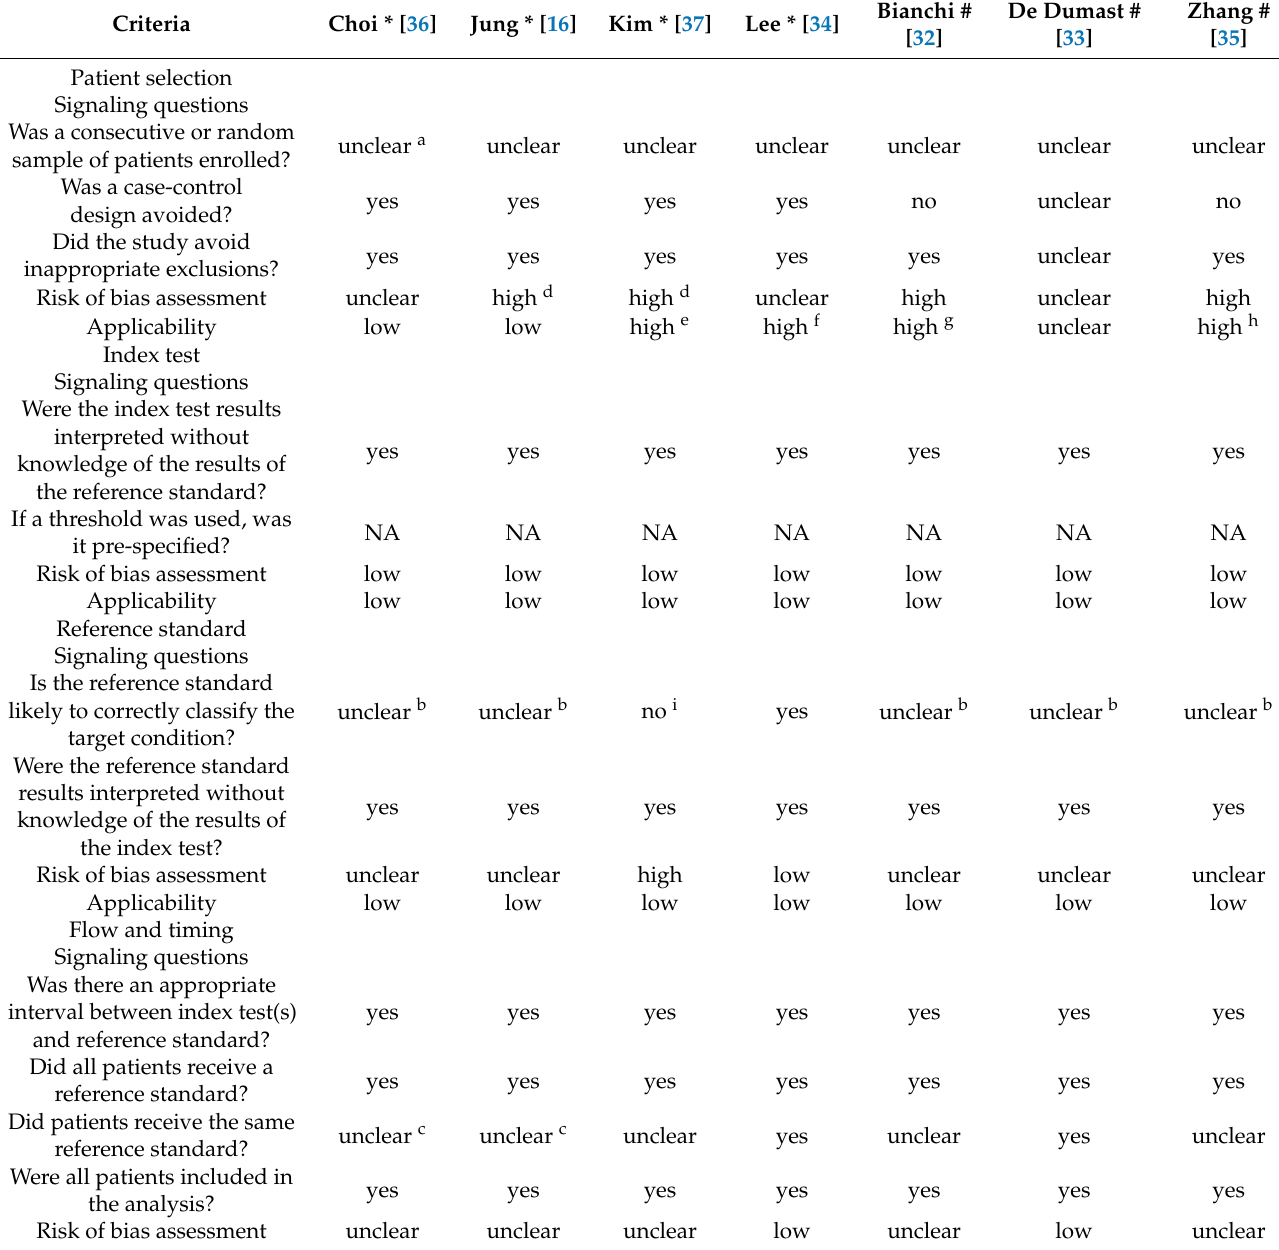
Table 2. QUADAS 2 risk of bias